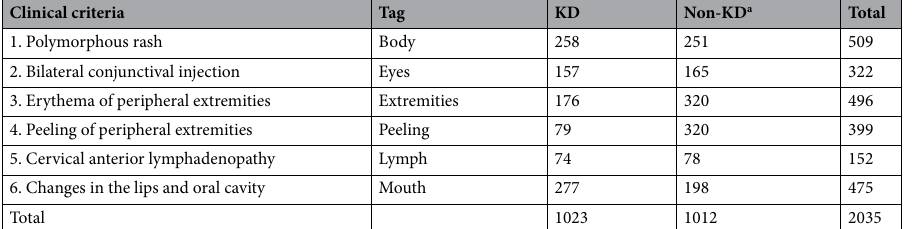
Table 1. Number of samples per clinical criteria in the KD-CNN dataset (prior to augmentation). Examples of search terms for Internet queries included “Kawasaki disease strawberry tongue,” “Kawasaki disease red eye,” “Kawasaki disease anterior cervical lymphadenopathy,” “Kawasaki Disease rash” for KD data and “hand foot mouth disease,” “scarlet fever,” “fifth disease,” “toxic shock syndrome,” “staphylococcal scalded skin syndrome” for non-KD data. Erythema and peeling are separated as clinical criteria to distinguish acute KD and subacute progressions for early diagnosis. Crowdsourced data was from 14 countries: US, France, Croatia, Slovakia, Albania, Philippines, Denmark, Canada, Mexico, UK, Indonesia, New Zealand, Australia, and Brazil. a The same datasets were used for both Erythema of peripheral extremities and peeling of peripheral extremities for non-KD, thus leading to a total of 1012 unique